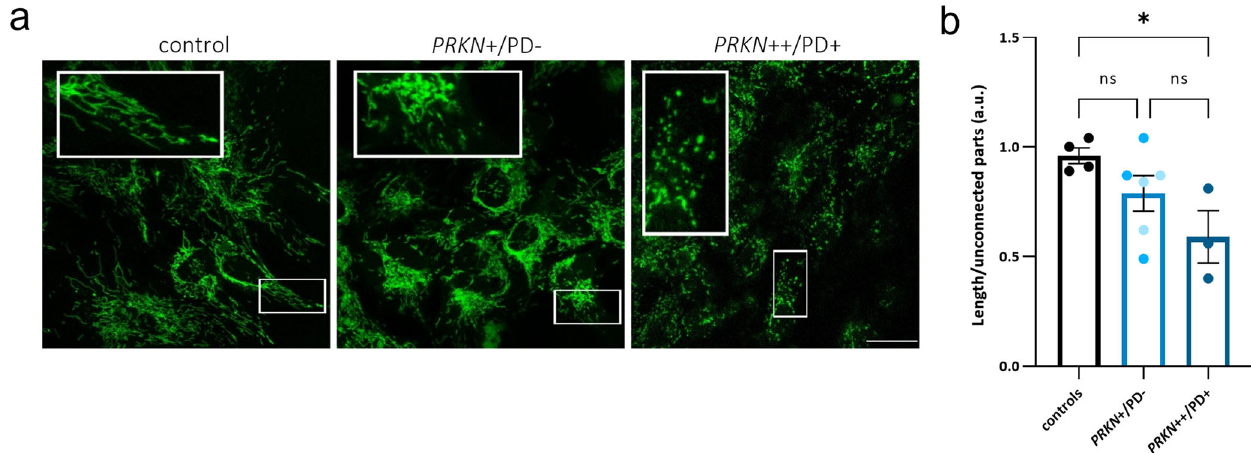
Fig. 5 Mitochondrial network morphology is unaltered in hiPSC-derived neurons of heterozygous PRKN variant carriers. a Confocal live imaging of hiPSC-derived neurons at day 50 of differentiation, stained with MTG. Scale bar: 25 µm. b Mitochondrial fragmentation measurements in hiPSC-derived neurons of a PD patient line with homozygous variants ( PRKN ++ /PD + ), the carriers group ( PRKN + /PD − ) comprising two heterozygous carriers ( PRKN + /PD − 1 and PRKN + /PD − 2, respectively color coded), and the control group (representing the mean values of three control lines per experiment). n = 4 independent experiments. Cell imaging and calculations were performed in at least 50 cells per sample for each experiment. Mitochondrial fragmentation was calculated with the fi lament function in Imaris Software: for each fi eld, the total length of the modeled mitochondrial network was calculated and divided by the number of unconnected parts. Error bars represent the mean ± SEM. p values were determined using one-way ANOVA followed by Tukey ’ s post hoc test to correct for multiple comparisons. * p ≤ 0.05. a.u. arbitrary units, ns not signi fi heterozygous PRKN variant carriers ( p = 0.049) as well as for the homozygous PRKN -PD patient neurons ( p = 0.008), compared to the control group (1.04 ± 0.04 vs. 0.93 ± 0.03 vs. 0.85 ± 0.05) (Fig.